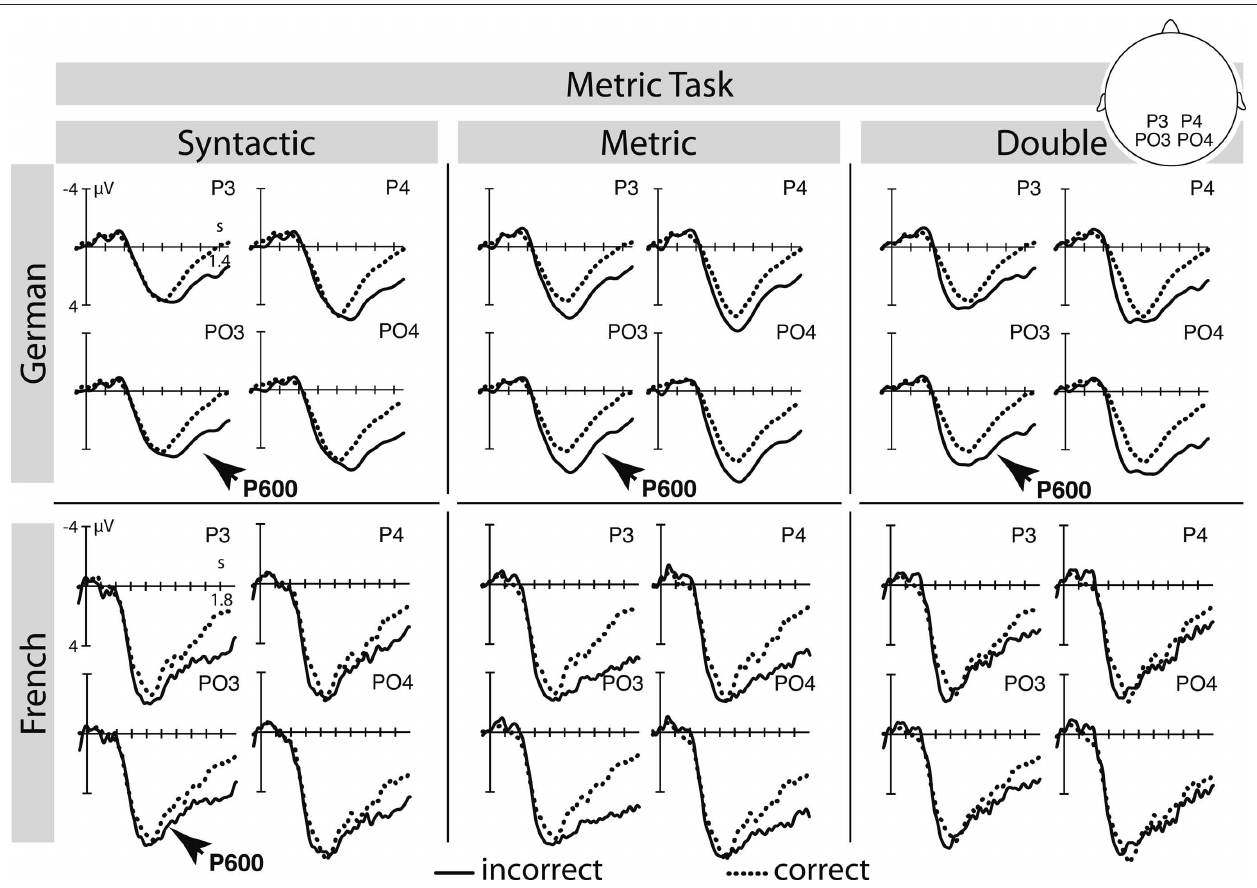
Figure 6 | german monolinguals and French L2 learners – metric task: selective erPs elicited by the critical main verb in the syntactic, metric, and the double violation condition. For a more detailled illustration please see Schmidt-Kassow and Kotz, 2009a for German monolinguals, and Schmidt-Kassow et al., 2011 for French